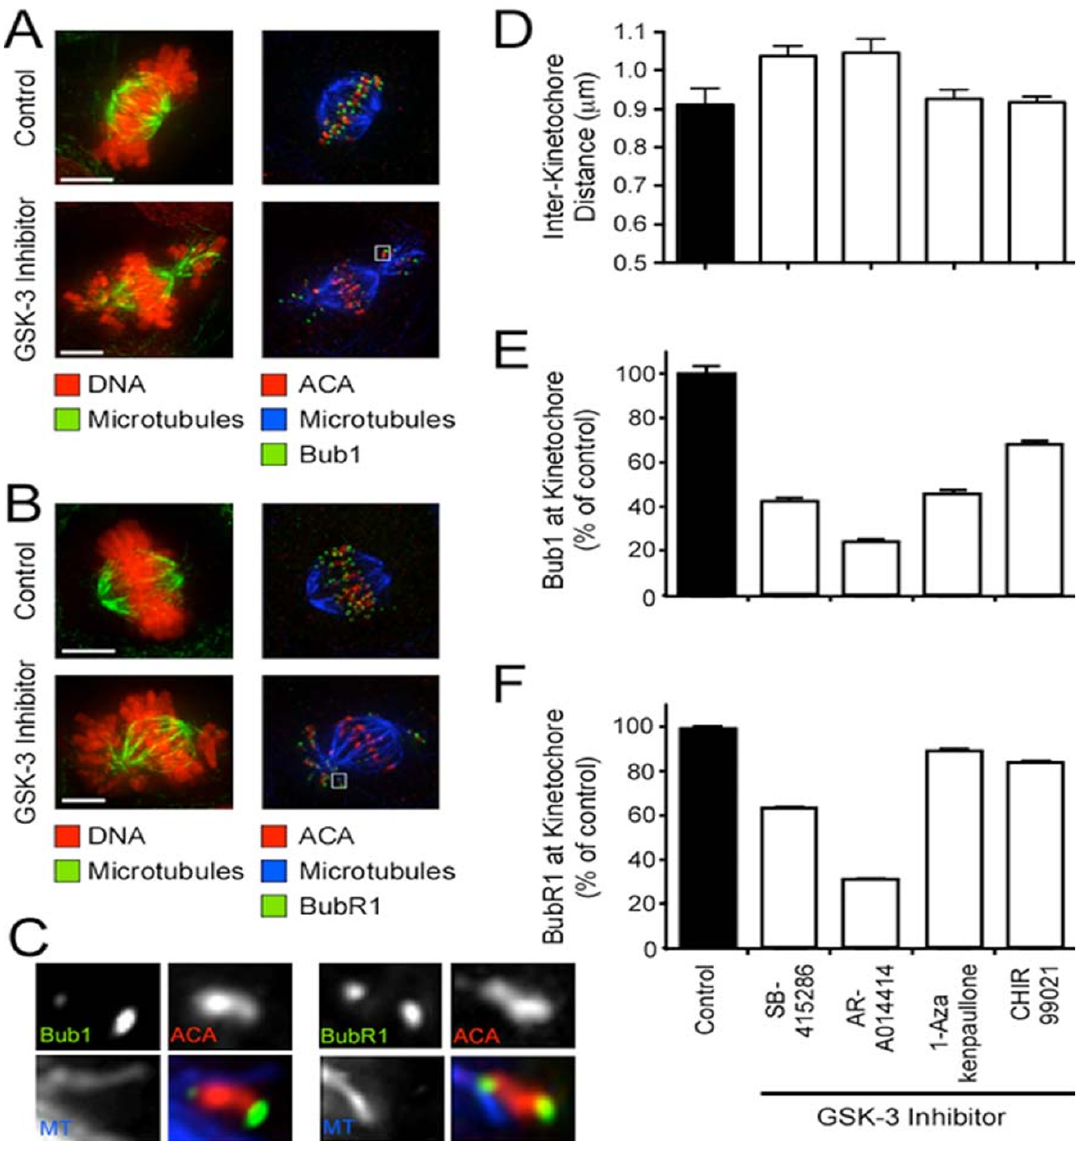
Figure 7 GSK-3 inhibitors increase inter-kinetochore distance . Drug-treated DLD-1 cells were fixed and stained to detect cen- tromeres (ACA, red), kinetochores (Bub1 or BubR1, green), microtubules (green or blue) and the chromosomes (red) as indi- cated. ( A, B ) Projections of deconvolved image stacks showing reduced levels of Bub1 and BubR1 is at metaphase- kinetochores is reduced in GSK-3 inhibitor treated cells. Scale bars: 5 µ m. ( C ) Projections of deconvolved image stacks show- ing the asymmetric labelling of Bub1 on the kinetochore of mono-orientated chromosomes. ( D ) Bar graph quantifying inter- kinetochore distance at metaphase chromosomes. Values represent the mean and s.e.m. derived from at least 20 kinetochores in at least 3 cells. ( E, F ) Bar graphs quantifying the levels of Bub1 and BubR1 at aligned chromosomes. Values represent the mean and s.e.m. derived from at least 64 kinetochores in at least 3 cells. The cells shown in (A) were treated with 30 µ M SB- 415286 and in (B) with 10 µ M